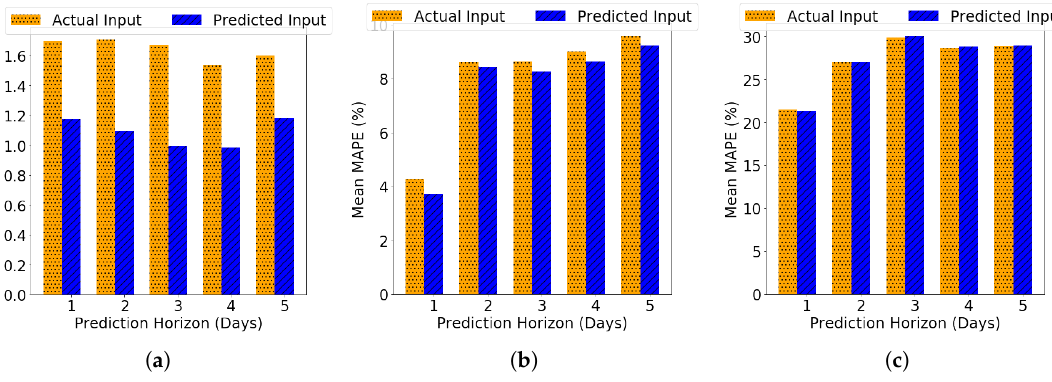
Figure 10. Mean of the MAPE of prediction when using Actual Temperature Input v/s Predicted Temperature Input in the GPR model for all the three loads. ( a ) CMU electricity load; ( b ) Y2E2 cooling load; ( c ) Y2E2 lighting